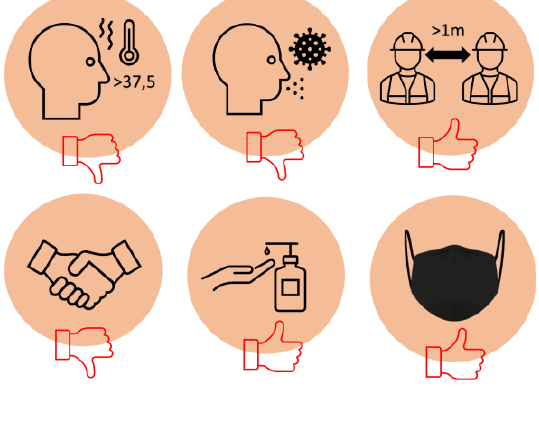
Figure 3 : Anti Covid-19 security measures on construction